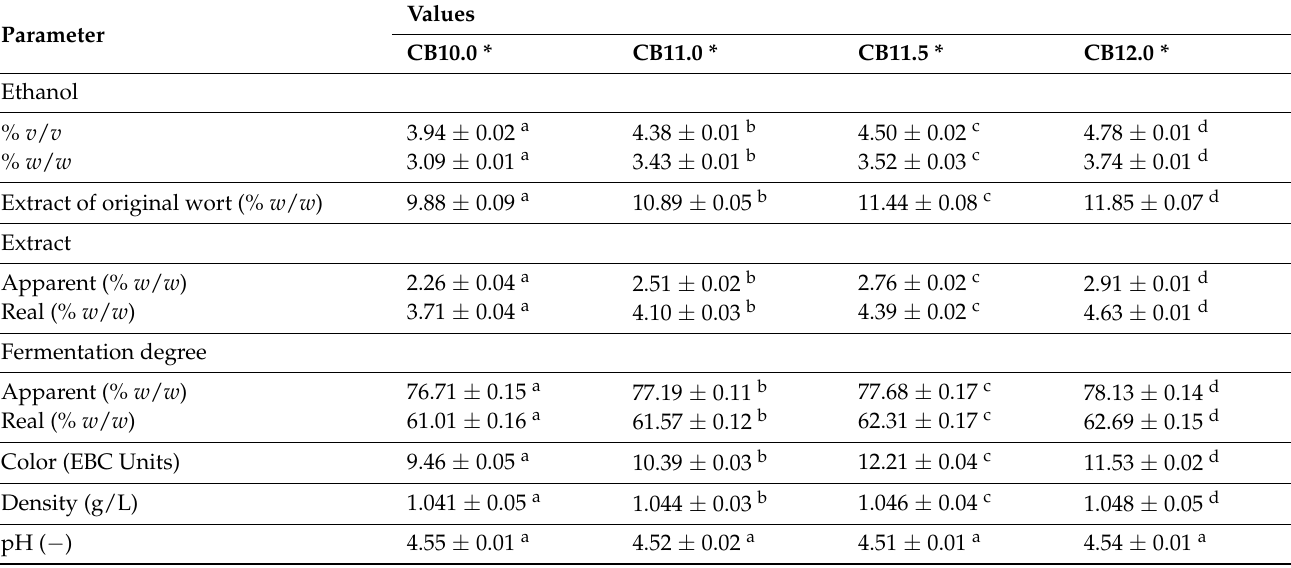
Table 2. Basic physicochemical parameters of the evaluated Czech lager beer